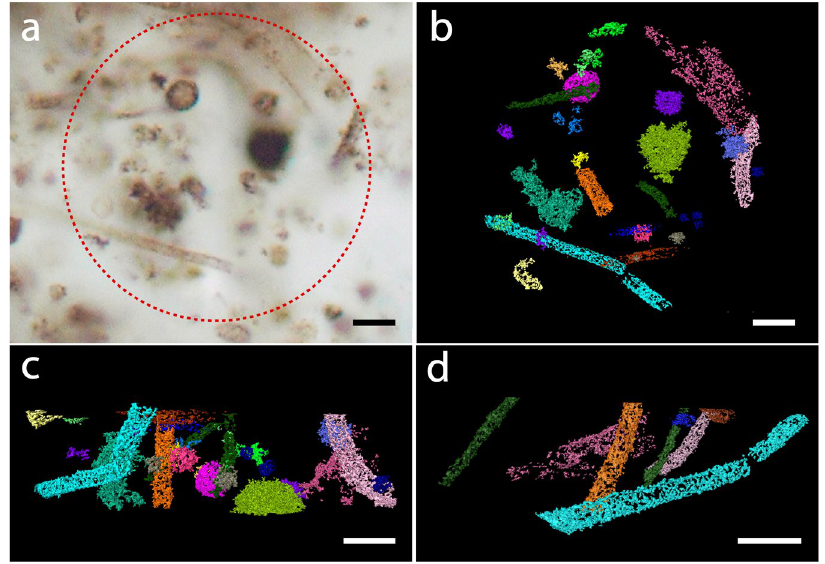
Figure 1. Fossilized microorganisms from the Schreiber Beach locality. ( a ) Optical photomicrograph of kerogenous microfossils. The circle indicates the region selected for PXCT analysis. ( b ) 3D rendering of the fossils distinguished in the PXCT data. ( b) Is at the same magnification and approximately in the same orientation as a . ( c ) Lateral view of the sample showing microfossils within the 10 µ m high sample analyzed using PXCT. ( d ) 3D rendering of Gunflintia filaments in the sample. Scalebars: 5 μ m.